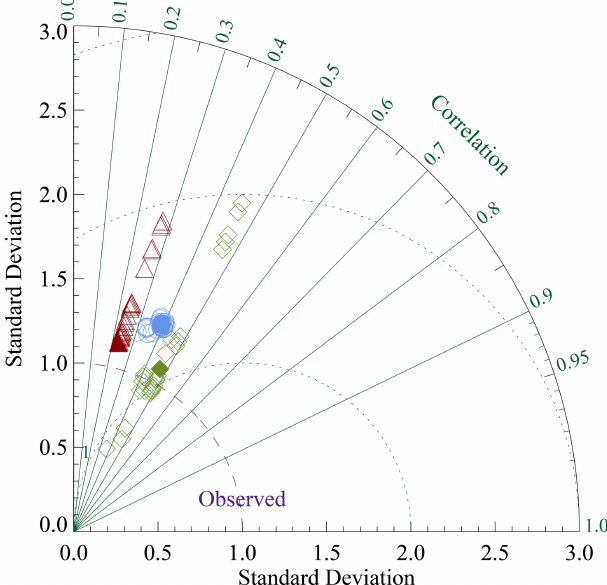
Figure 3. Taylor diagram showing the results of the parameter sen- sitivity experiments carried out with COUPSIM: %Calcite (blue cir- cles); %TOC (green diamonds); %Opal (red). The full symbols in- dicate the combination found for the best-fit experiment. Maps for the surface sediment compositions of this best-fit experiment are shown in Fig.